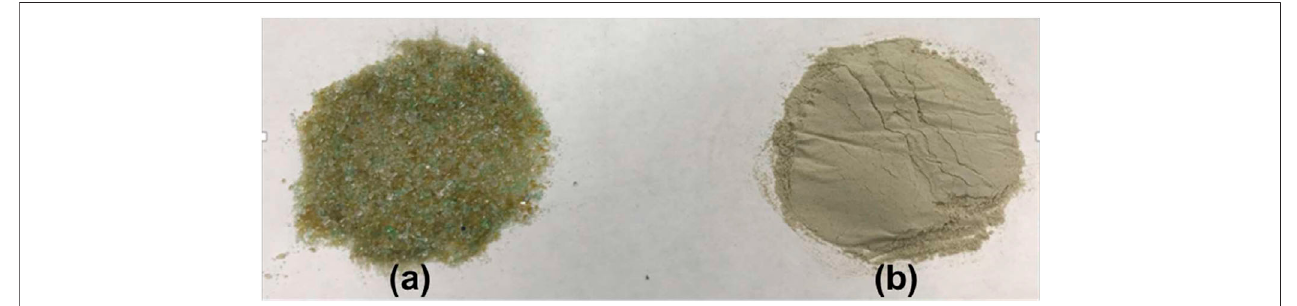
FIGURE 1 | Waste glass as received (A) and after milling (B) .